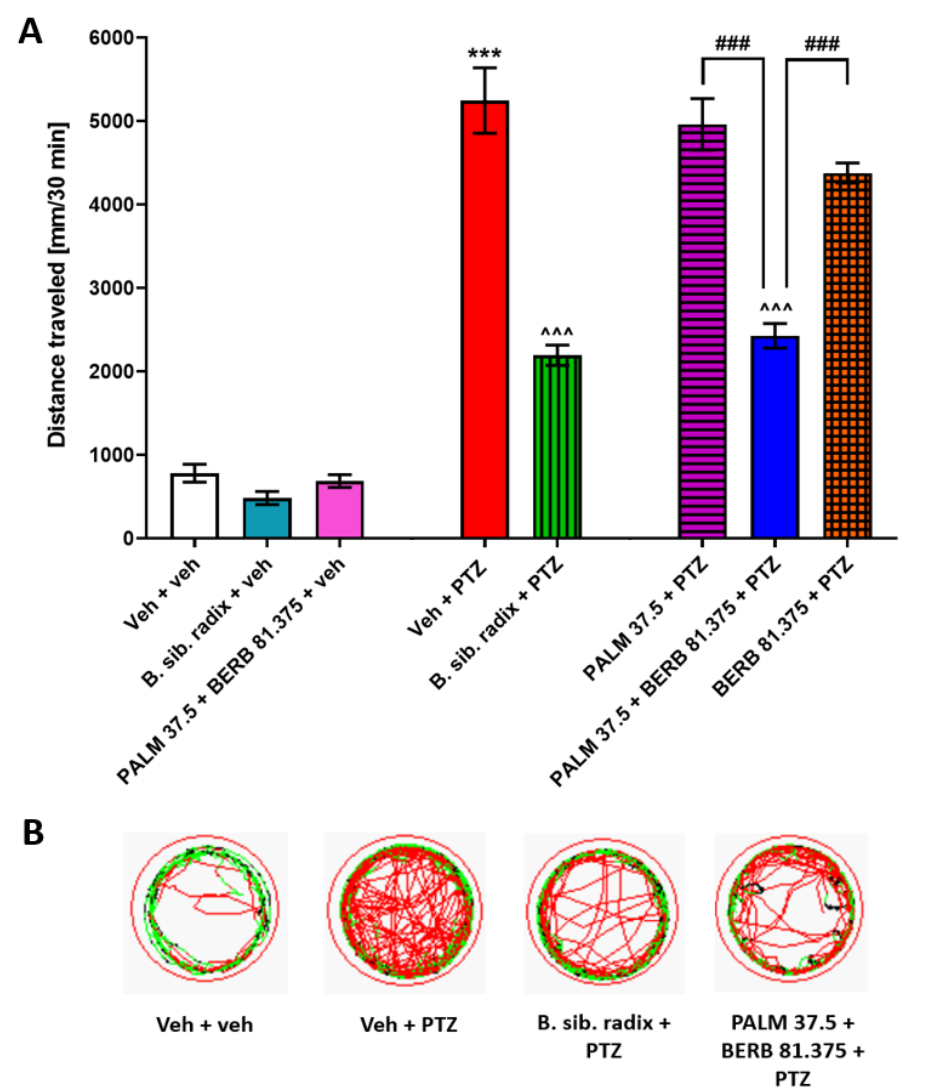
Figure 7. The influence of extract of Berberis sibirica radix and the combination of PALM and BERB in 1:2.17 ratio corresponding to the natural proportions of both alkaloids in the plant on the seizure-like behavior in the zebrafish PTZ-induced hyperlocomotion assay. Extract of Berberis sibirica radix (100 µ g / mL) and alkaloids PALM (37.5 µ M) and BERB (81.375 µ M) alone or in combination were used. Seven dpf zebrafish larvae, after 24 h preincubation with investigated compounds alone or in combination, were exposed to 20 mM PTZ. Seizure-like behavior was assessed 5 min after acute PTZ exposure. Results of the assay are presented as ( A ) total distance traveled during 30 min of assay, and ( B ) digital tracking map of larvae at second (5–10 min) interval of experiment: large movement—red, small movement—green. Data were analyzed using one-way ANOVA, followed by the Tukey’s post-hoc test. Data are depicted as a mean ± SEM. Veh + veh ( n = 36), B. sib. radix + veh ( n = 24), PALM 37.5 + BERB 81.375 + veh ( n = 32), Veh + PTZ ( n = 45), B. sib. radix + PTZ ( n = 47), PALM 37.5 + PTZ ( n = 40), PALM 37.5 + BERB 81.375 + PTZ ( n = 48), BERB 81.375 + PTZ ( n = 32). *** p < 0.001 vs. Veh + veh; ˆˆˆ p < 0.001 vs. Veh + PTZ; ### p < 0.001 vs. respective group. B. sib. radix— Berberis sibirica radix ,